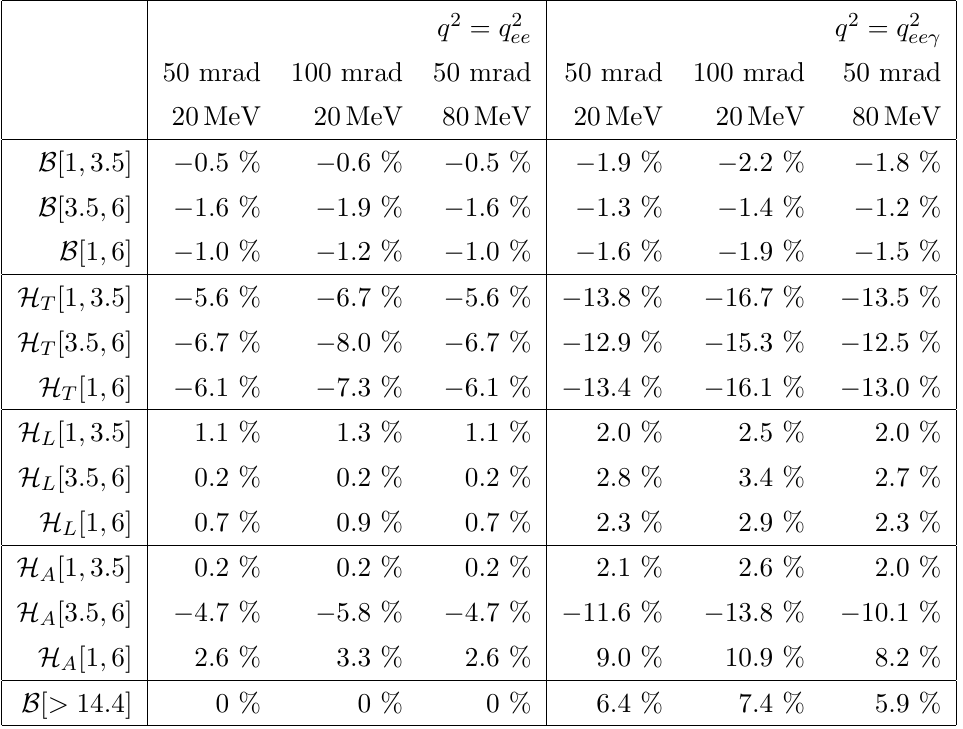
Table 3 . Correction factors to the SM predictions presented in section 3 required for a direct comparison with measurements performed using the two experimental strategies q 2 = q 2 as de(cid:12)ned in the